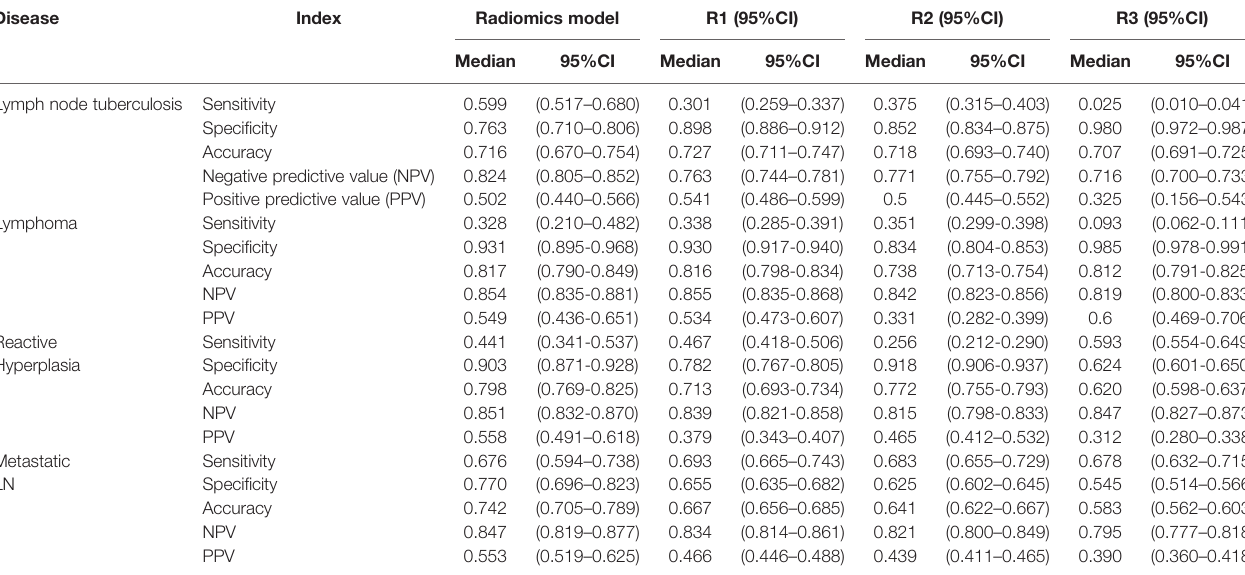
TABLE 2 | Comparison between radiomics model and senior radiologists in training set.